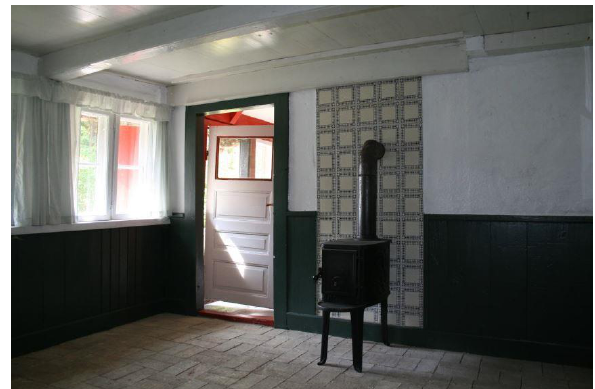
Figure 6. The living room before the architectural conservation (Photographer Søren Kibsgaard).